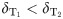
Schematic of the HIV replication cycle and mechanism of interference by treatment-approved drug classes.Free viruses are cleared by the immune system with a rate constant CL. Further, free viruses can be also cleared during unsuccessful T-cell infection CLT through the destruction of essential viral components of the reverse transcription-, or pre-integration complex [37, 38]. The term β represents the lumped rate of infection of T-cells, including the processes of virus attachment to the cell, fusion and reverse transcription, leading to an early infected cell T1, before proviral integration. Similarly, the term k denotes the rate by which early infected T1 cells are transformed into productively infected T2 cells, involving proviral integration and cellular reprogramming. The term NT denotes the rate of production of infectious virus progeny by productively infected T2 cells. The rates β, CLT, k and NT may be modified by different antiretrovirals as indicated by bars (inhibition) and pointers with plus sign (drug-dependent increase). The terms δT1<δT2 denote the rates of clearance of T1 and T2 cells respectively and δPIC denotes the rate of intracellular destruction of the pre-integration complex. CRA: Co-receptor antagonists, RTIs: reverse transcriptase inhibitors, InIs: Integrase inhibitors, PIs: Protease inhibitors.